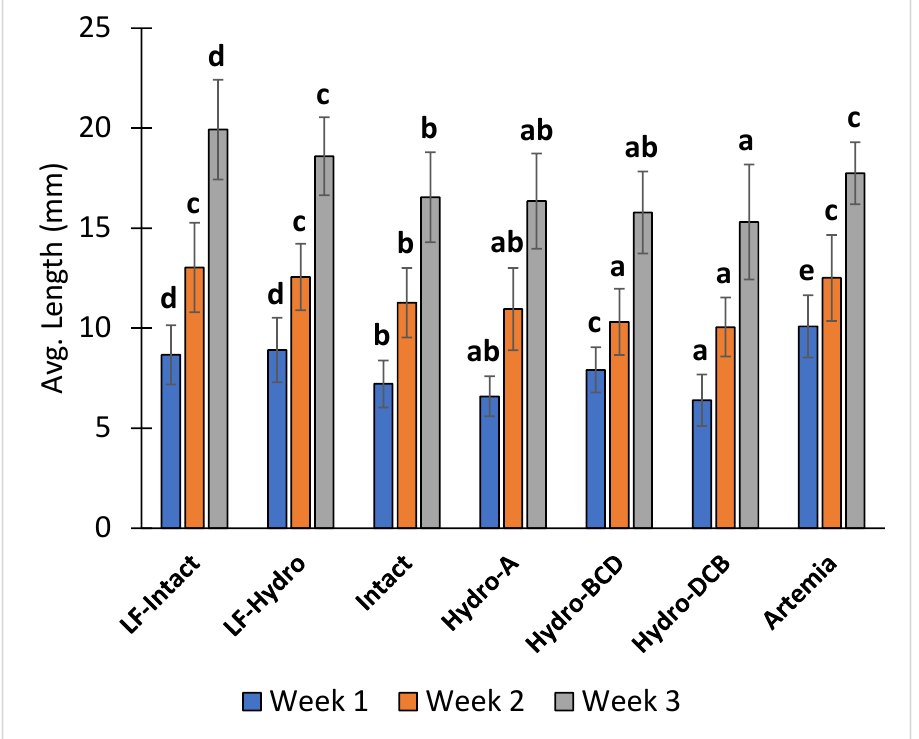
Figure 5. Diet effect on the average total length at the end of each week. Values are presented as means and error bars represent standard deviation for total length. Letters indicate statistical significance between groups. The significance was determined using a One-Way ANOVA and a Tukey test with a p value < 0.05.